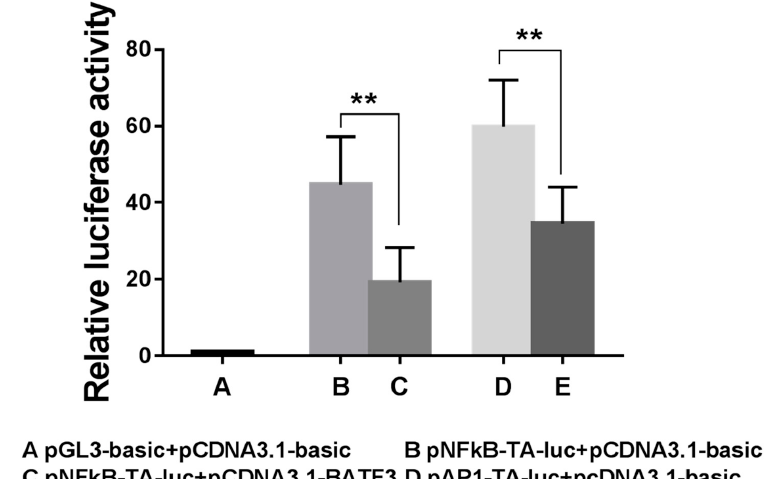
Figure 8. Impact of CiBATF3 on AP-1 and NF- κ B reporter gene. HEK293 cells were transfected with 0.25 µ g pCDNA3.1-CiBATF3, 0.25 µ g reporter gene vectors (pNF қ B-TA-luc and pAP1-TA-luc, respectively), 0.025 µ g pRL-TK renilla luciferase vector and 1 µ L Lipo6000™ Transfection Reagent. At 24 h post-transfection, the cells were collected and lysed. Luciferase activities were measured using the Luciferase Assay System (Promega). The results are presented as the mean ± SD ( n = 3). Differences were considered significant at p <